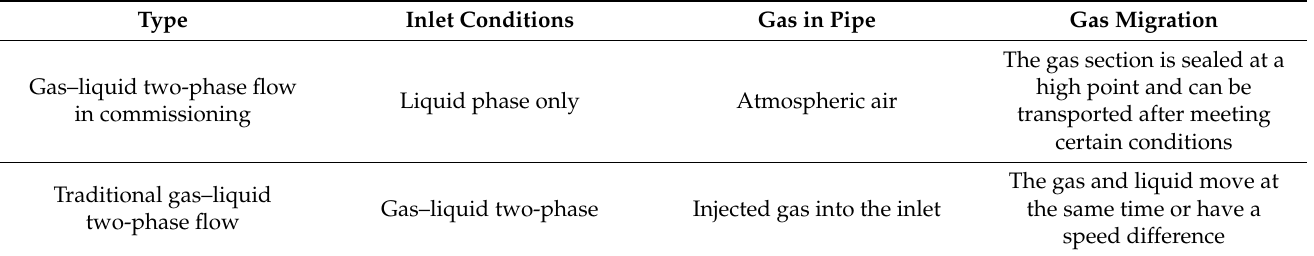
Table 1. Differences between gas–liquid two-phase flow in pipe commissioning process and the traditional gas–liquid two-phase